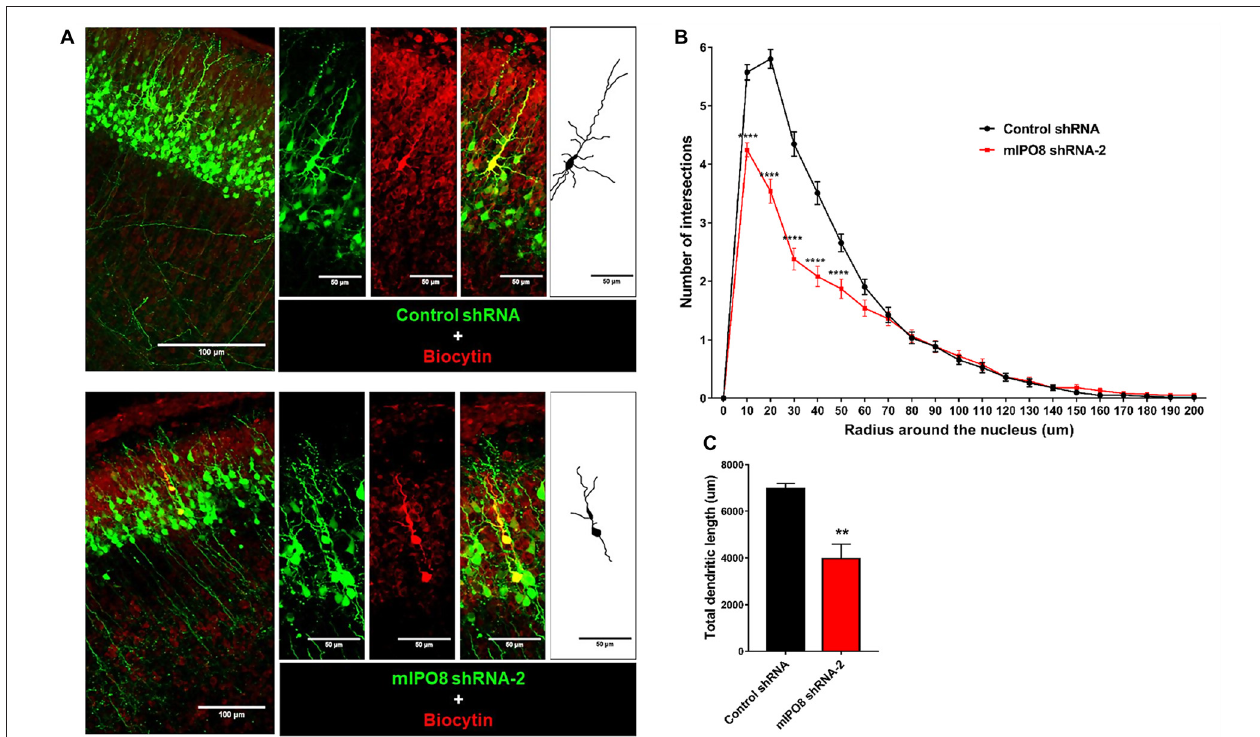
FIGURE 5 | The dendrite tree of projection neurons at P5 is influenced by IPO8. (A) High magnification images and schematic drawing of EGFP expressing neurons filled with biocytin. The experimental conditions are the same as in Figure 4 . (B) Scholl analysis of the dendritic complexity. (C) Total dendrite length of neurons. ∗∗ p < 0.01, ∗∗∗∗ p <